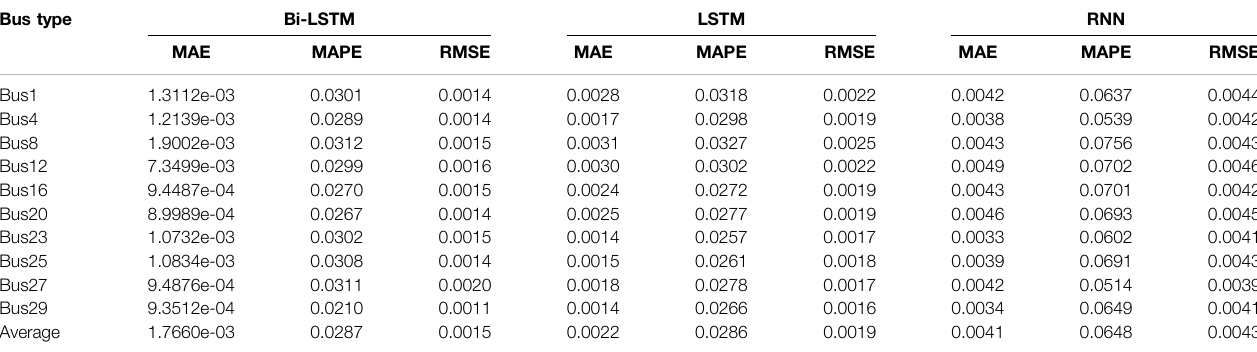
TABLE 5 | Comparison of different learning mechanisms ’